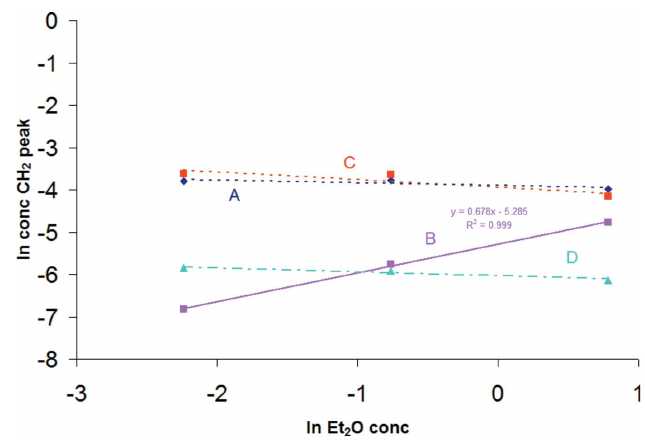
Figure 7 ln–ln plots of the total ether concentration on the x -axis and the concentration of the species represented by the CH 2 —Al peaks on the y - axis for the three samples with approximately equal total concentration of CH 2 (AlBr 2 OEt 2 ) 2 . The relative amount of the species with peak B increases with ether concentration, while the other peaks